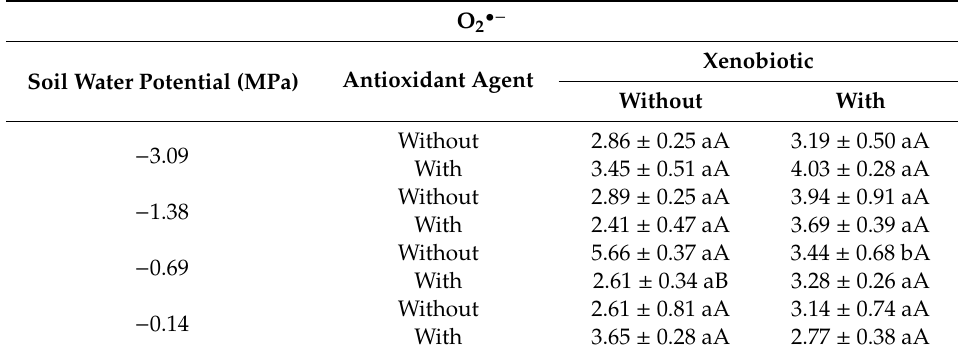
Table 9. Superoxide (mmol protein − 1 min − 1 ) in soybean plants submitted to di ff erent soil water potentials and xenobiotic and antioxidant agent applications.